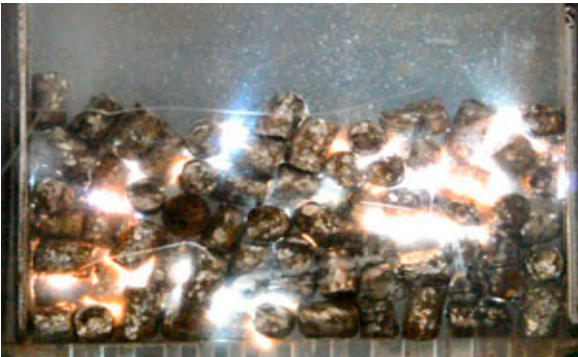
Figure 2. A typical type of single electrospark.